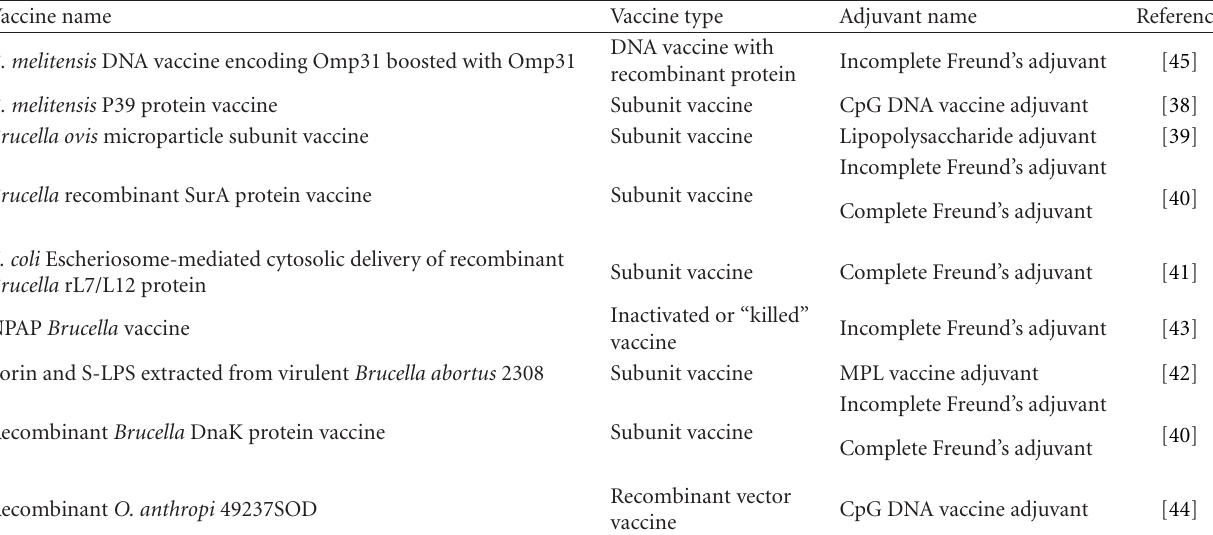
Table 6: Brucella vaccines with adjuvants in